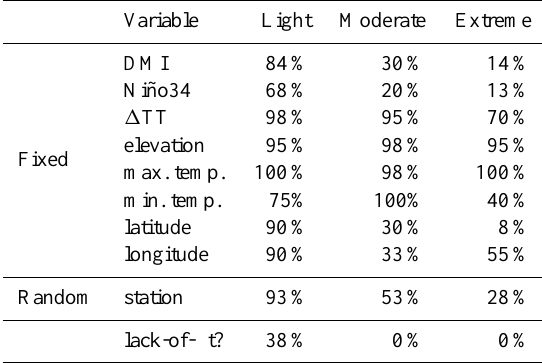
Table 6. This table indicates the percentage of significant p values at α = 0.05 level for each of the 1973–2013 models. p values for fixed coefficients and goodness-of-fit test are from LRTs on GLM fits. p values for the variance components are from LRTs that com- pare GLM and glmer